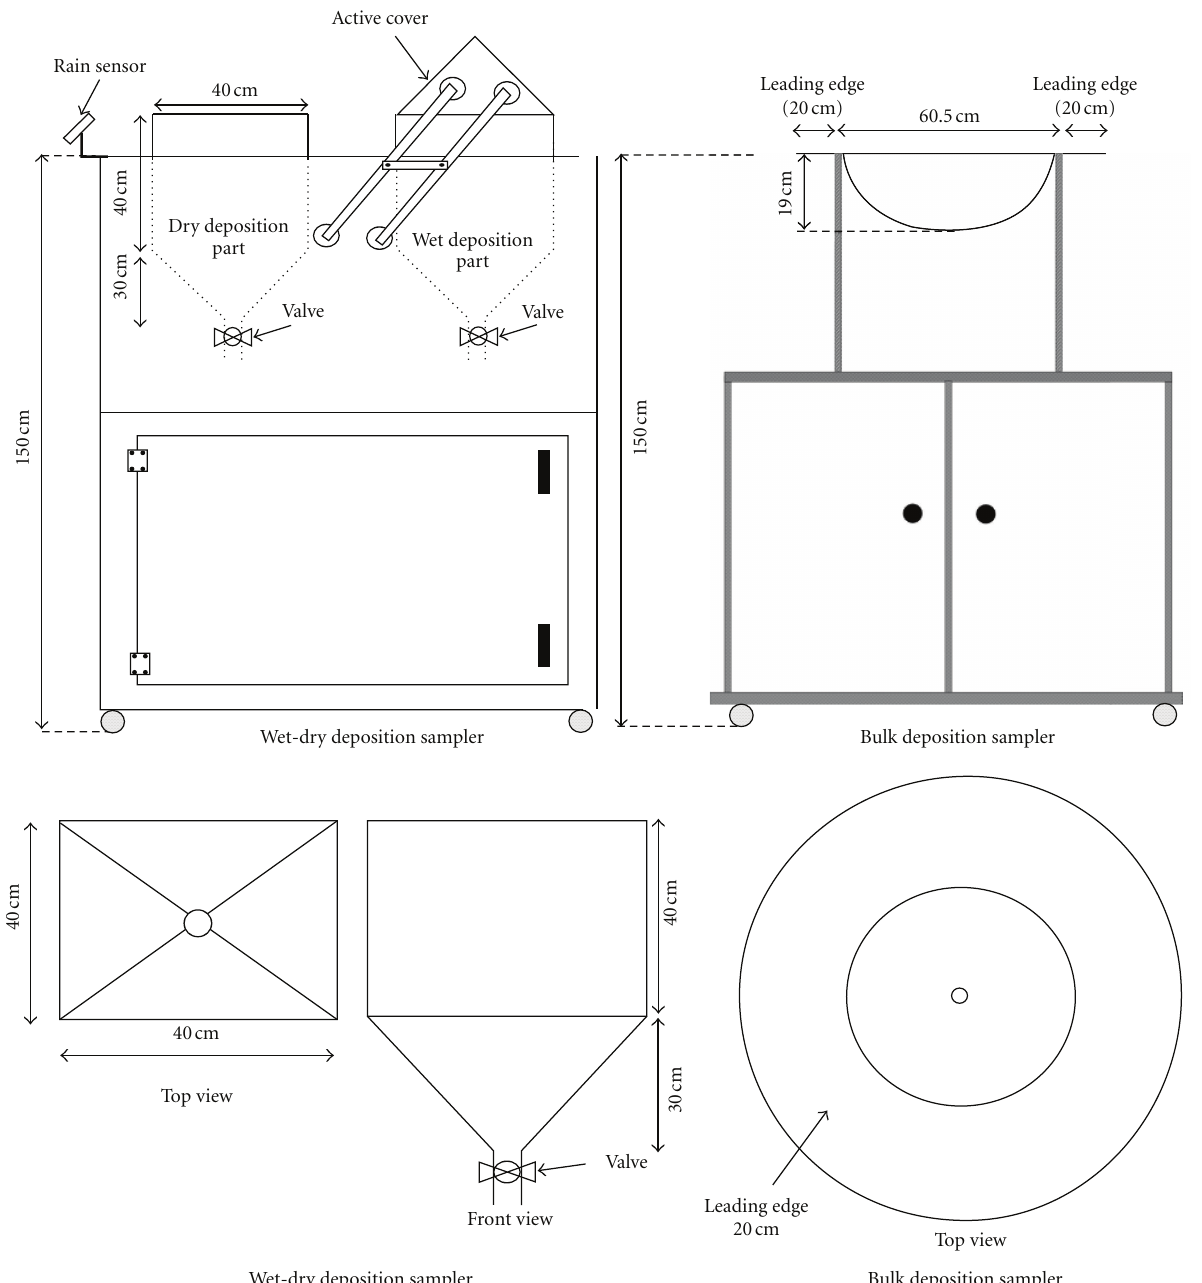
Figure 1: Schematic display of wet dry deposition sampler (WDDS) and bulk deposition sampler